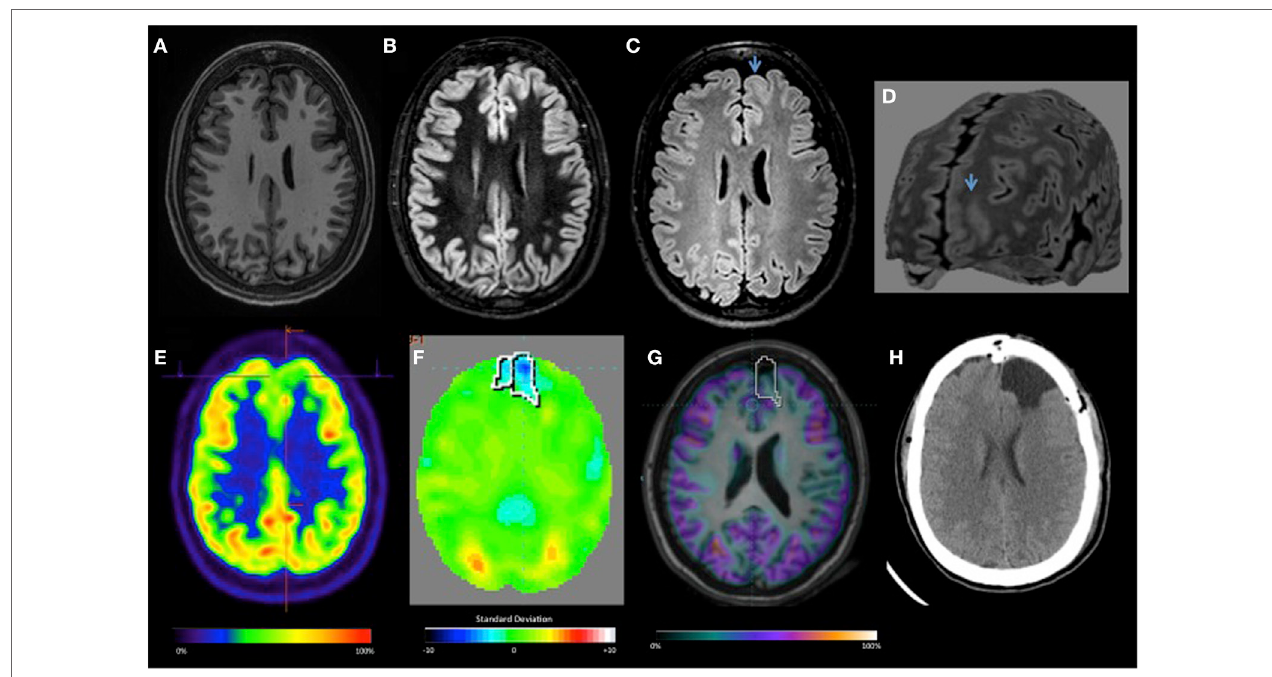
FigUre 2 | Focal cortical dysplasia II-B left frontal lobe: (a–D) T1, double inversion recovery, FLAIR axial MRI, and curvilinear reconstruction, showing abnormal cortical thickening, focal increased signal, white and gray matter junction blurred (arrow). (e) Visual-positron emission tomography (PET) initially was considered normal. (F) Quantitative-PET showed − 3.6 SD in the left frontal lobe. (g) Co-registration MRI and PET. (h) Axial CT after surgery